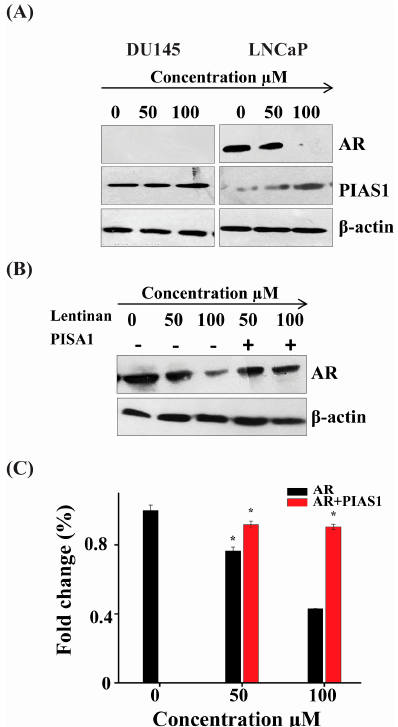
Figure 5. ATR II induces LNCaP cells apoptosis through regulation inhibition of AR and up- regulation of PIAS1. ( A ) LNCaP cells were treated with ATR II (0, 50 and 100 µM) for 48 h. The cellular proteins were extracted to detect the levels of AR and PIAS1 as well as β -actin (control) by Western blotting. ( B ) LNCaP cells were transfected with or without PIAS1, then treated by ATR II (0, 50 and 100 µM) for 48 h then the protein expression of AR as well as beta-actin were evaluated by western blot. ( C ) LNCaP cells line were transfected with or without PIAS1, then treated by ATR II 0, 50 and 100 µM for 48 h then RT-PCR was performed to detect the fold change of AR. (* p < 0.05 compared with the control).